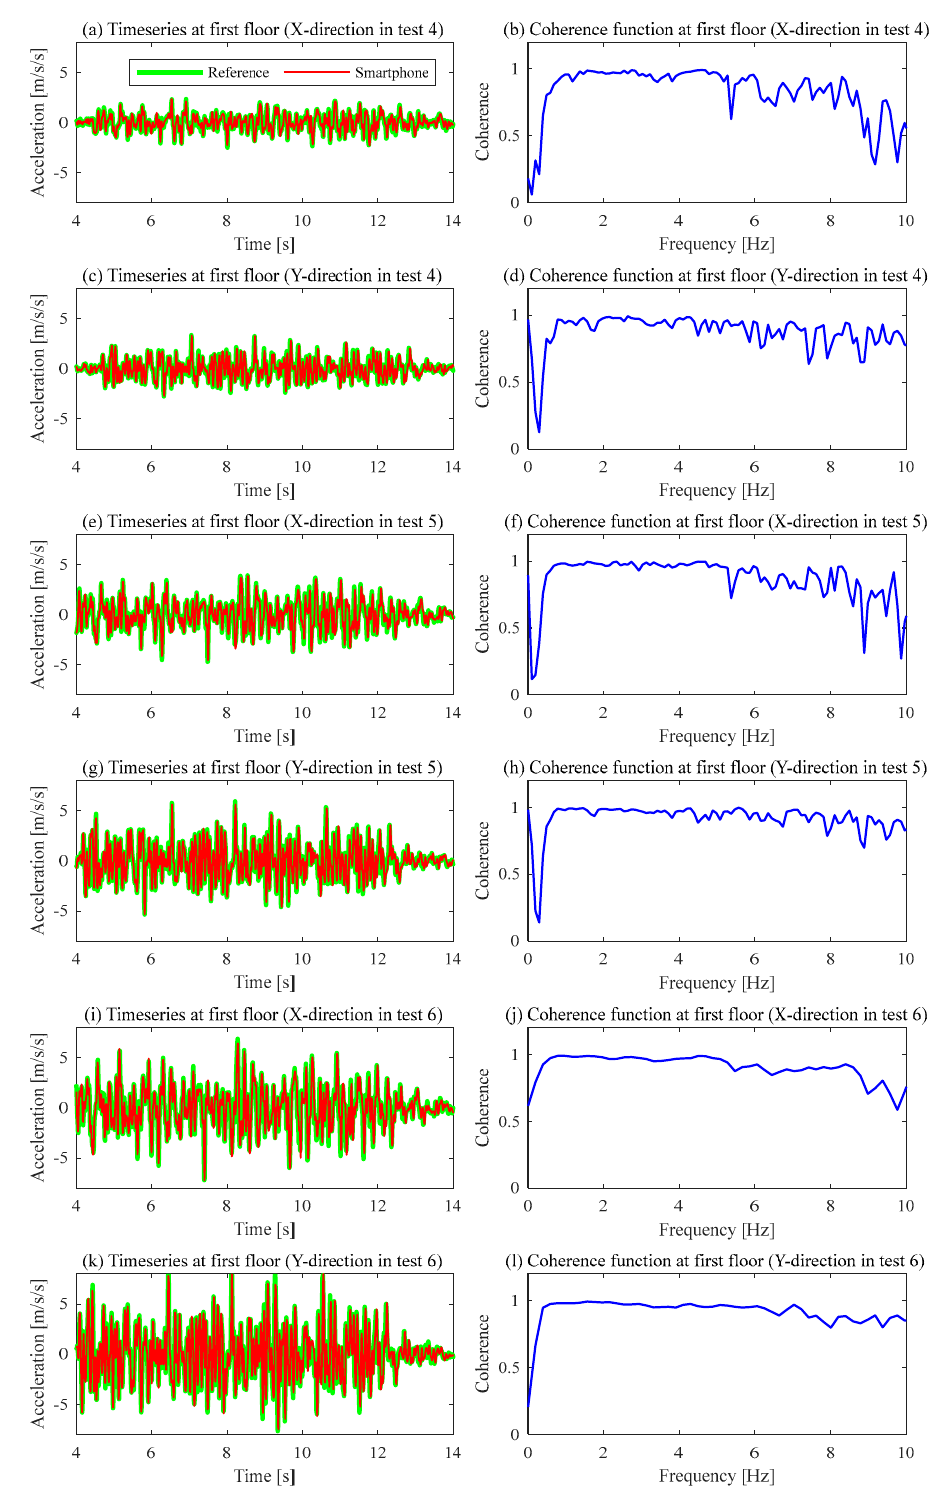
Figure 6. Comparison of time series between acceleration obtained from reference accelerom- eters and smartphones, and coherence for the X and Y directions in tests 4 to